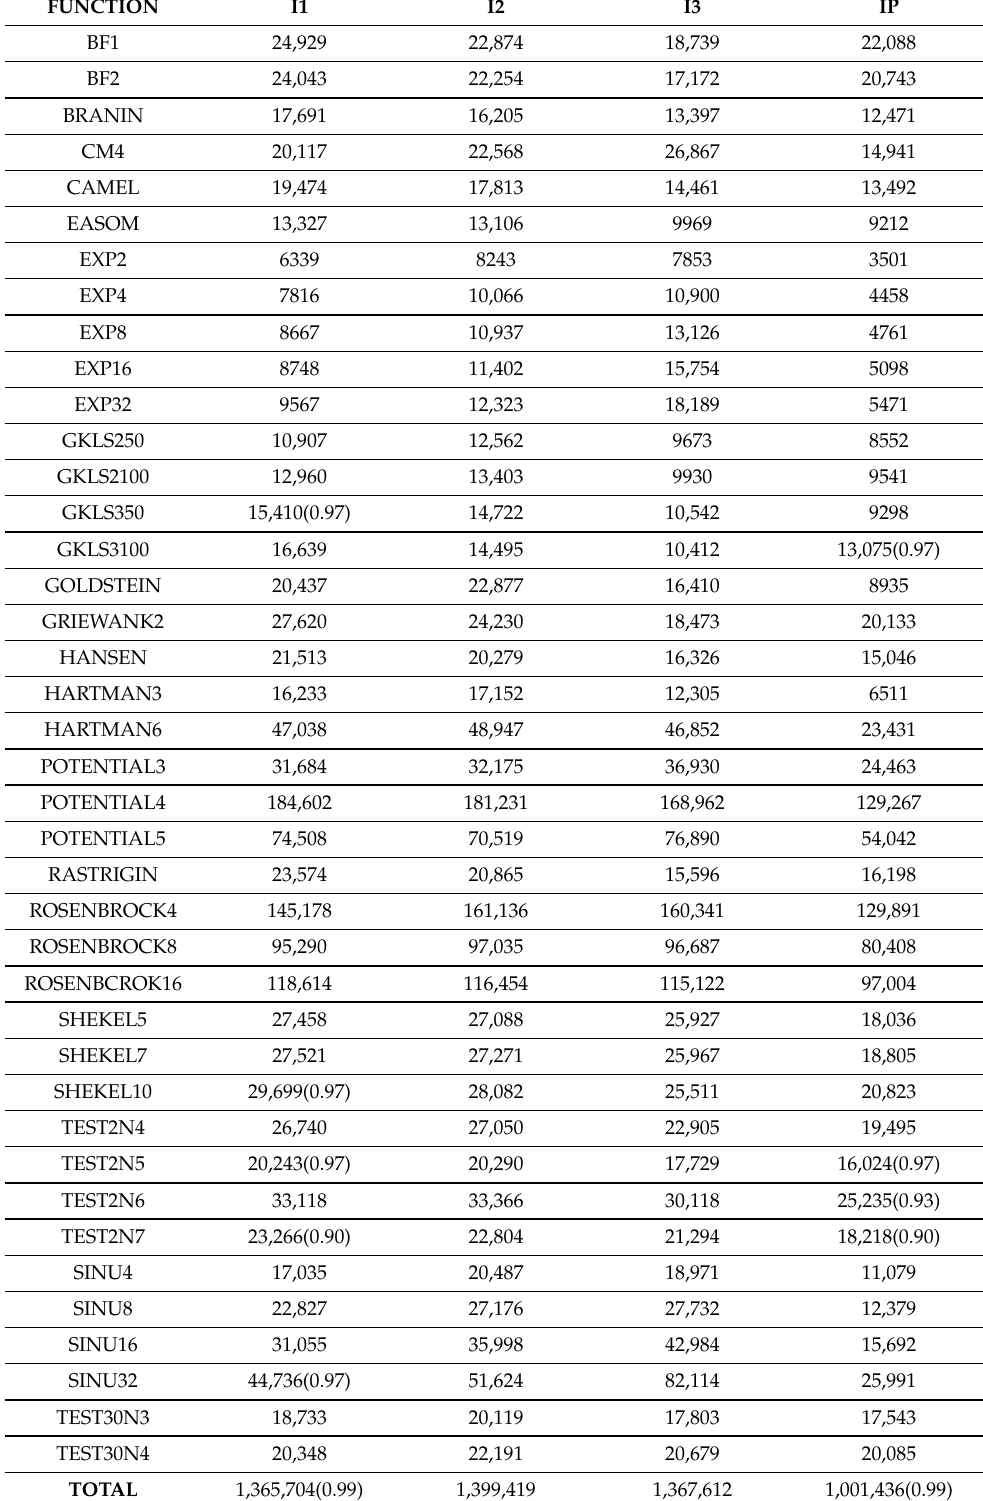
Table 2. Experiments with the Ali stopping rule without gradient